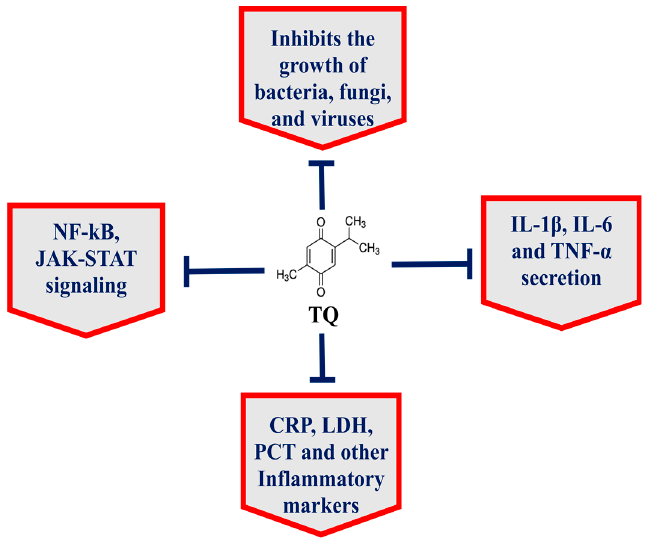
Figure 1. TQ exhibits multitargeting behavior in the treatment of various